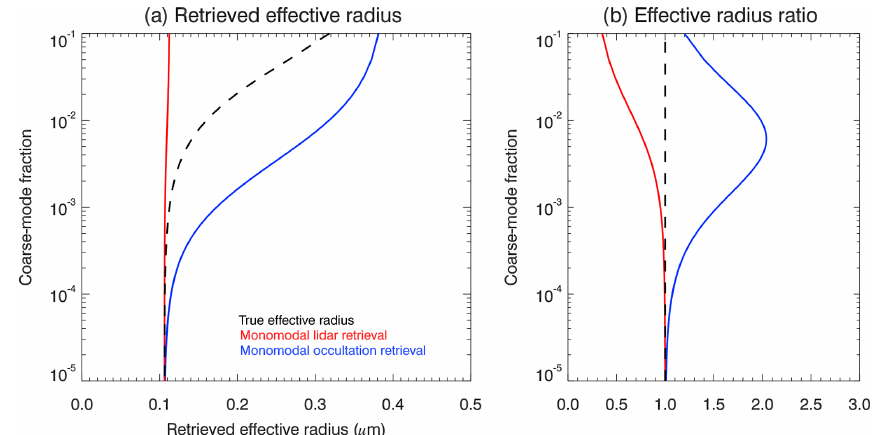
Figure 4. (a) The coarse-mode fraction dependence of retrieved effective radius r eff is shown for an assumed monomodal log-normal particle size distribution with S = 1 . 4 based on simulated lidar (red line) and satellite occultation (blue line) measurements. The black dashed line corresponds to the true effective radius of the bimodal particle size distribution assumed for the forward simulations. (b) Ratio of the retrieved effective radii and the true effective radius of the bimodal log-normal distribution.